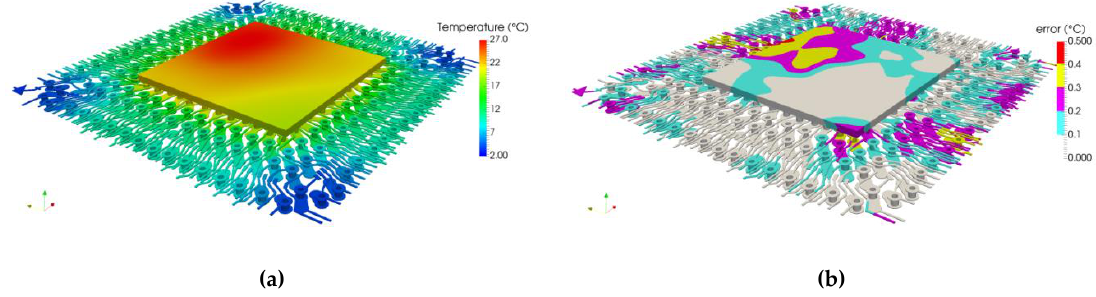
Figure 13. Temperature field ( a ) computed by the reduced model of order 300 at t = 37 s. Error ( b ) with the finite elements simulation at the same time.